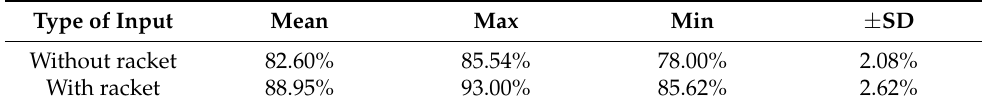
Table 1. Obtained Accuracy results for A3T-GCN.